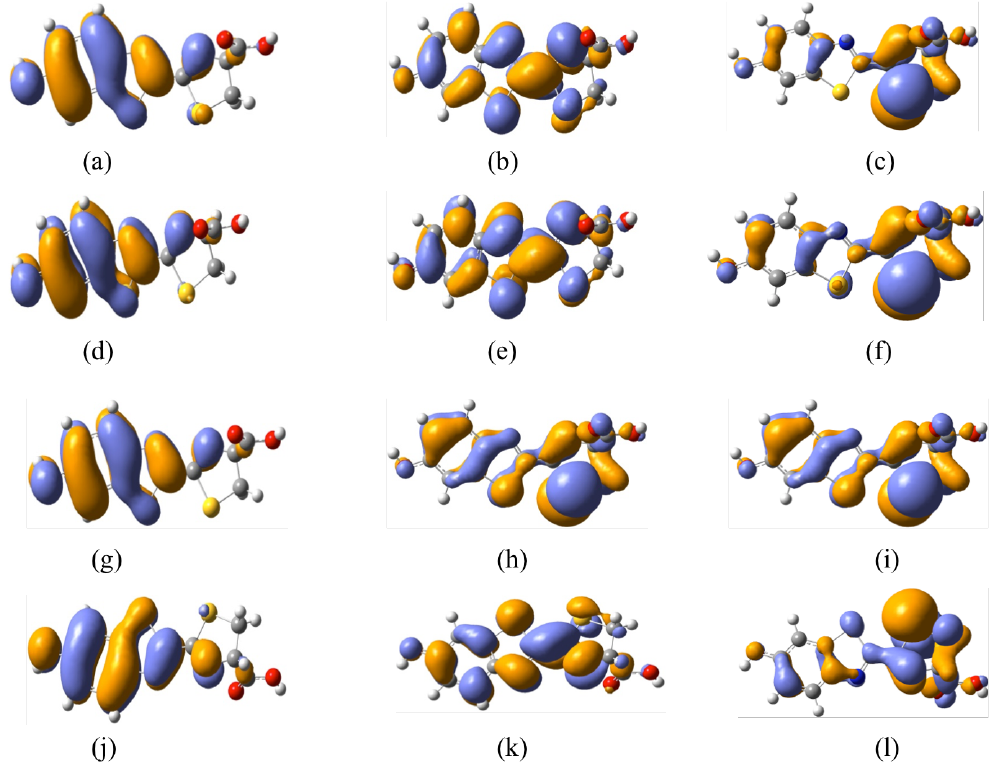
Figure 2. HOMO, LUMO, and HOMO-1 of D-luciferin molecule: ( a – c ) in gas phase; ( d – f ) in cyclohexane; ( g – i ) in ethanol; and ( j – l ) in toluene